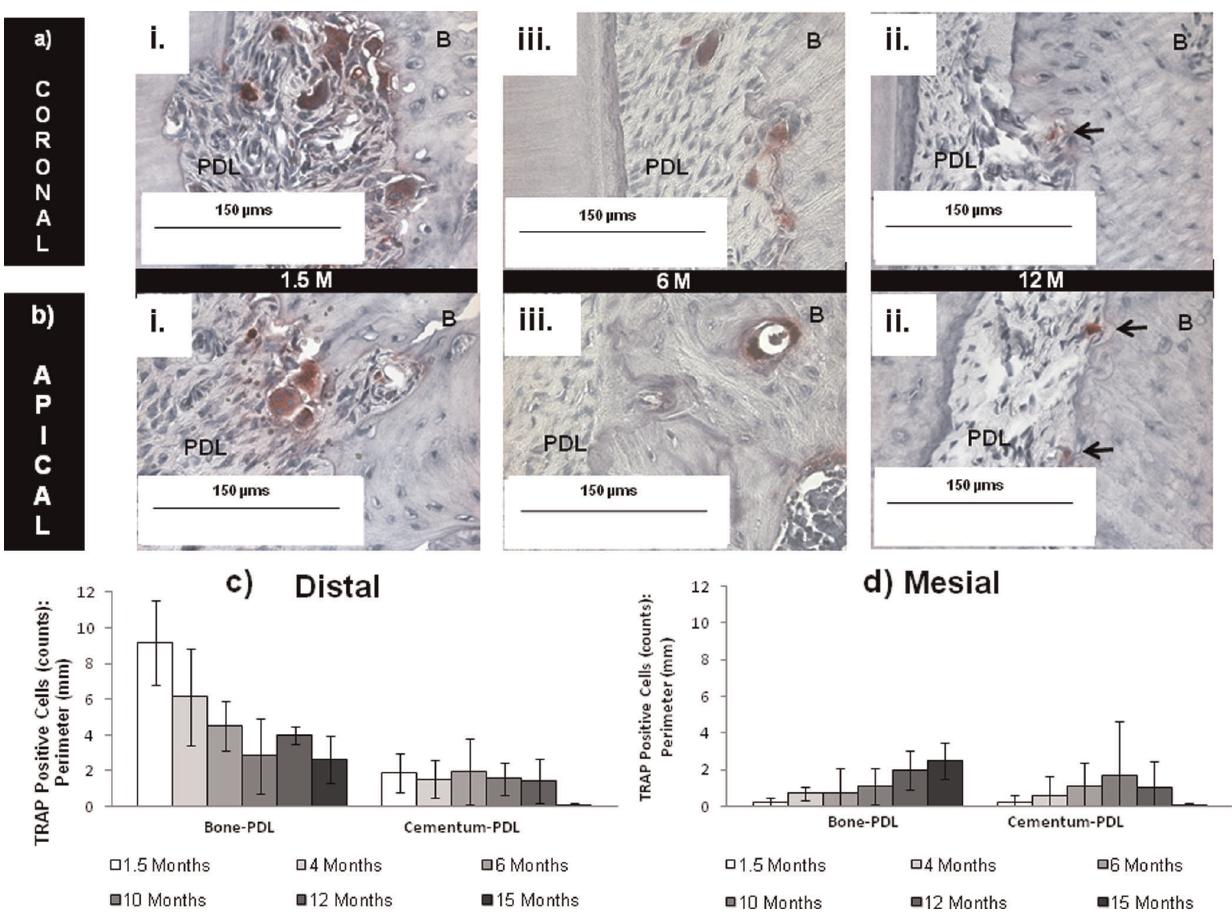
Figure 3. Regions of osteoclastic activity with age. Enlarged at 40X from encircled areas in Figure 1, TRAP localization is demonstrated across all age groups in a) coronal and b) apical regions. In young rats, resorption activity is represented by robust multinucleated pits (red staining) surrounded by several dark purple nuclei. In older rats mononucleated pits predominated with decreased intensity of red stain. Scale bar=150 m m. Results show osteoclastic activity declined with increasing age in c) distal regions and d) increased in mesial